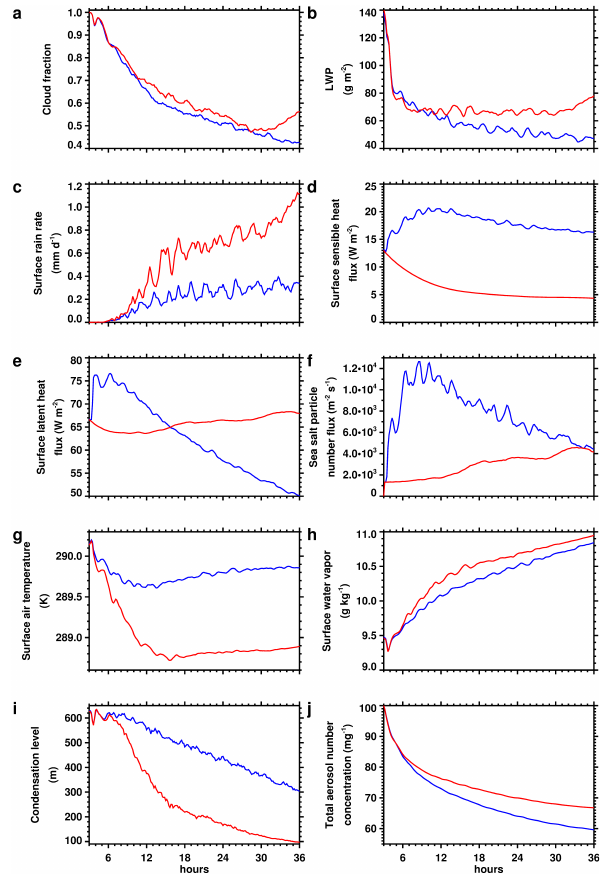
Fig. 13. Domain-averaged time series of selected quantities in sim- ulation S ◦ (blue) and S ⊗